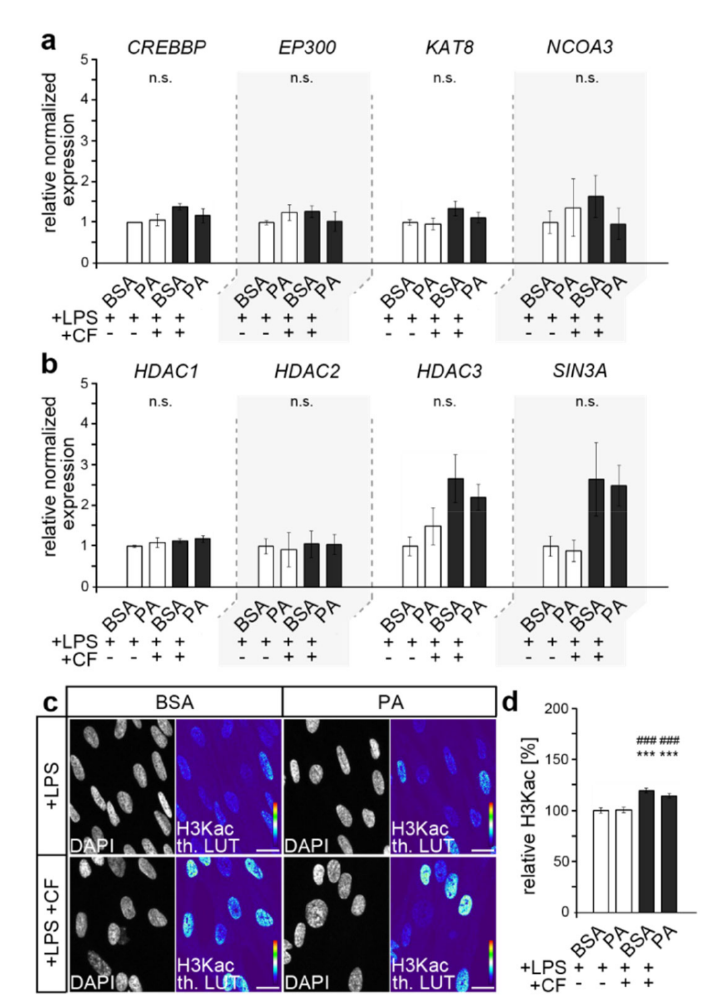
Figure 1. Palmitic acid did not impact H3Kac in compressed HPdLFs stimulated with P. gingivalis LPS. ( a , b ) Quantitative expression analysis of genes encoding histone acetyl transferases ( CREBBP , EP300 , KAT8 , NCOA3 ) in ( a ) and genes encoding proteins relevant for histone deacetylation ( HDAC1 , HDAC2 , HDAC3 , SIN3A ) in ( b ) in human periodontal ligament fibroblasts (HPdLFs) exposed to palmitic acid (PA) and simultaneously stimulated with compressive force (CF) and P. gingivalis LPS and compared to BSA+LPS controls. ( c , d ) Representative micrographs of global H3K9/14/18/23/27 acetylation (H3Kac) of HPdLFs under previous conditions. H3Kac staining intensity is shown in thermal LUT (th. LUT) analyzed in relation to BSA+LPS control ( c ). Cell nuclei were visualized with DAPI. *** p < 0.001 in relation to BSA+LPS; ### p < 0.001 in relation to PA+LPS; n.s., no significant difference between the conditions. One-way ANOVA and post hoc test (Tukey) were used for analysis. Scale bars: 10 µ m in ( c